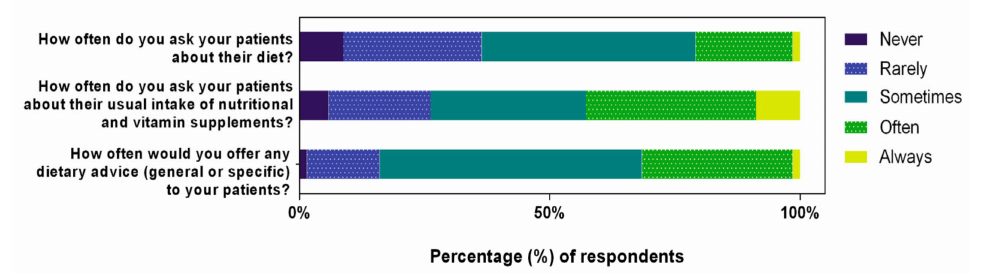
Figure 2. Optometrists’ self-reported clinical practices as related to diet and nutritional supplementation. Percentage (%) of respondents, from n = 206, who selected each frequency of practice, on a five-step Likert